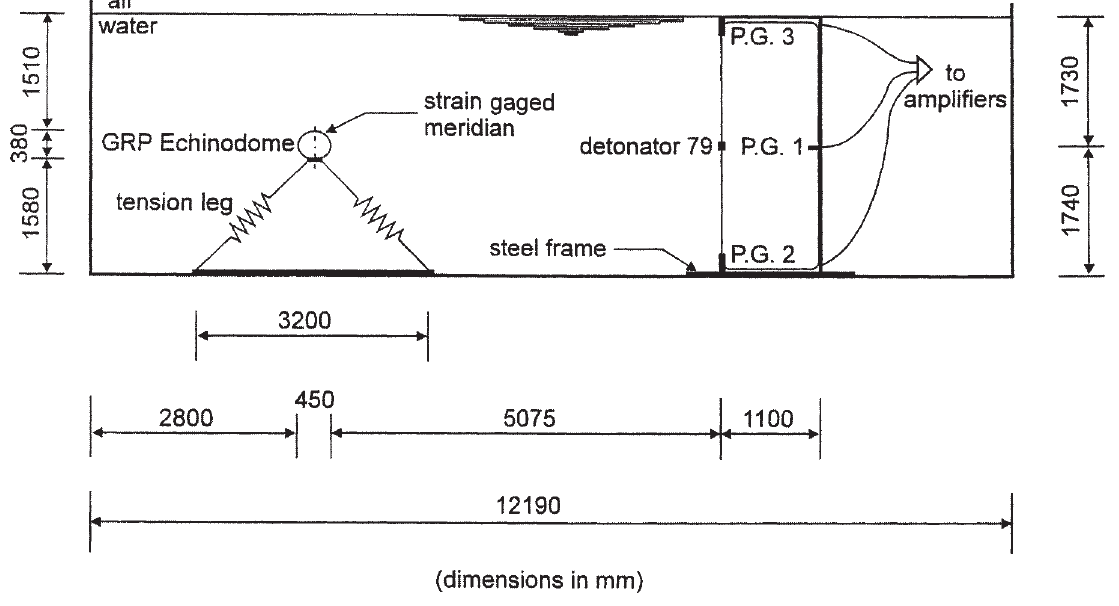
Fig. 3. Prototype location in water tank for underwater explosion tests (PG = pressure